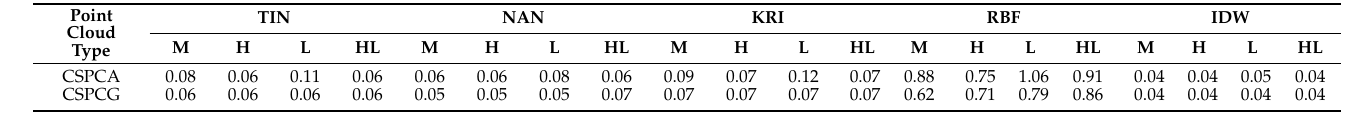
Table 3. Summary of the contribution of pixels with positive depth values in percentage